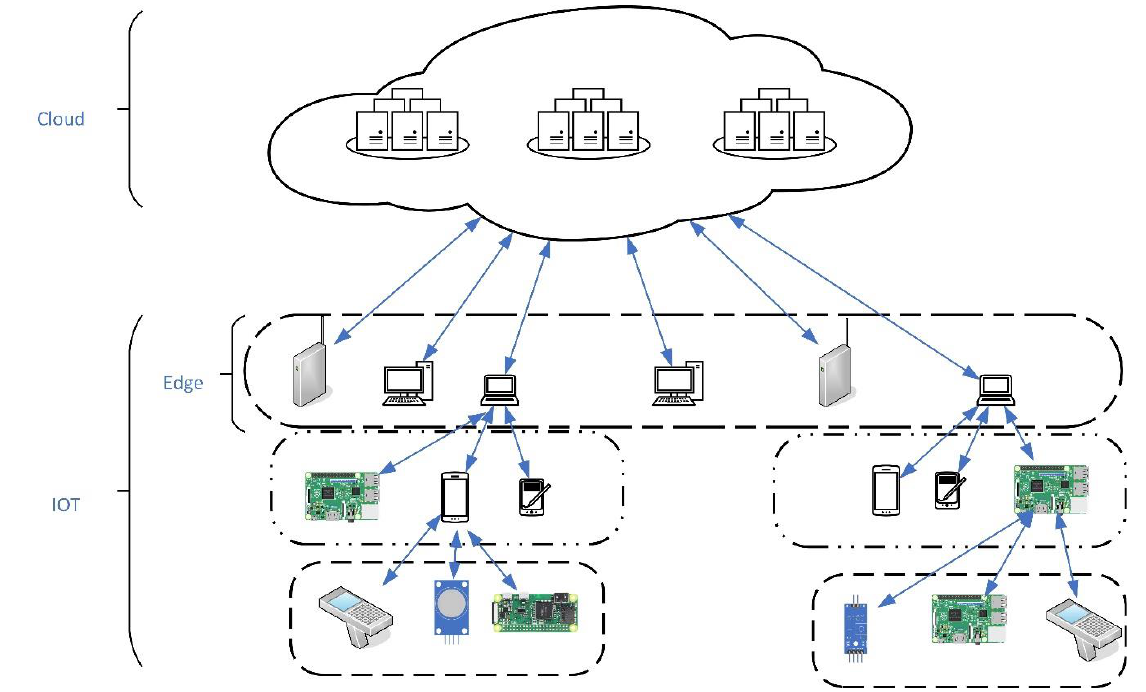
Figure 1. Device categories and their blockchain levels.